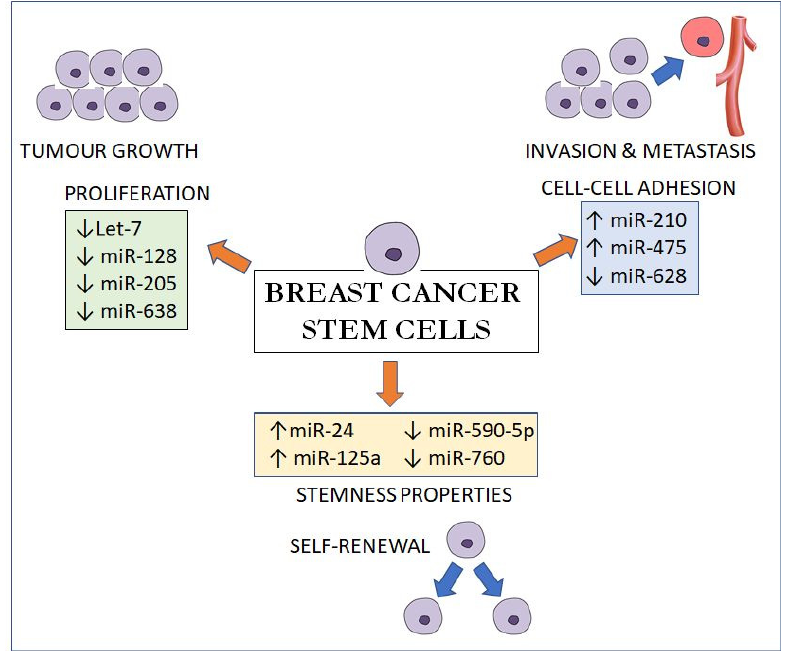
Figure 1. MicroRNA e ff ects on breast cancer stem cells on proliferation, cell-cell adhesion and stemness properties. In the era of precision medicine, gene-targeting, immunomodulatory and cell-based therapies